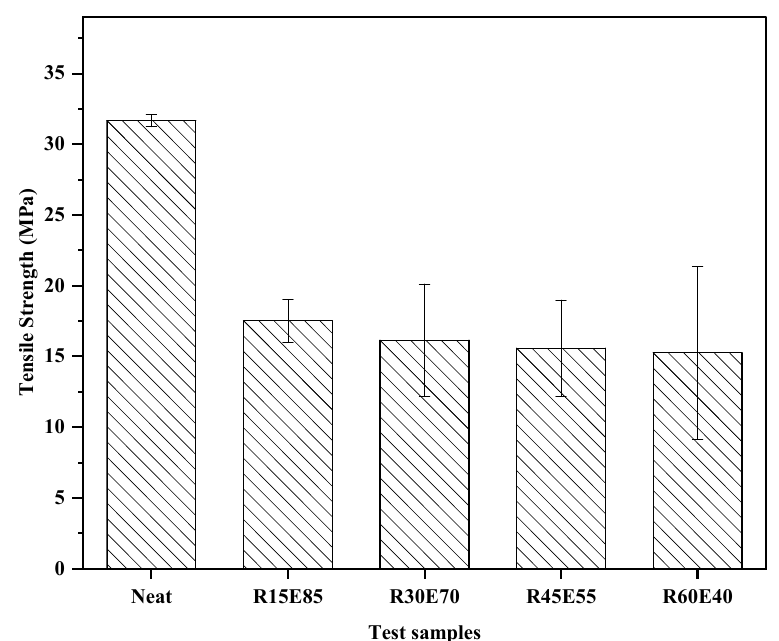
Figure 8. Tensile strength of the test samples.